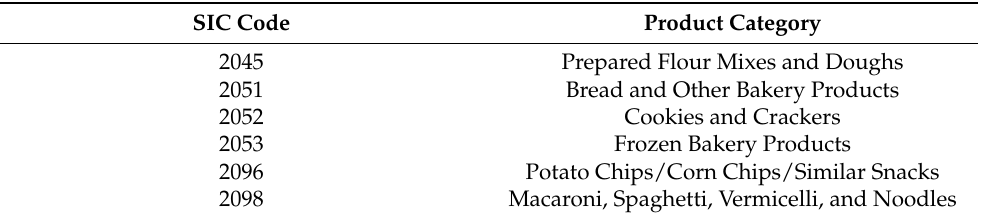
Table 1. Standard Industrial Classification (SIC) codes of food manufacturing firms targeted in this